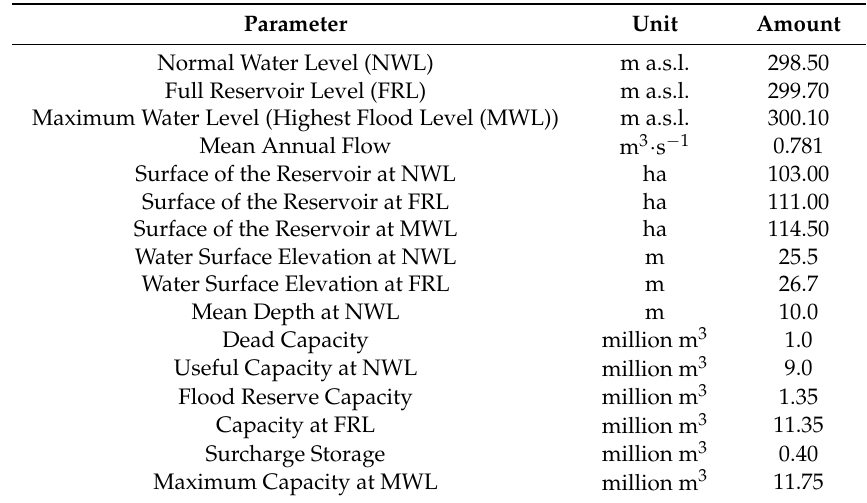
Figure 1. Location of the Dobromierz Reservoir. Table 1. Basic parameters of the Dobromierz Reservoir Table 1. Basic parameters of the Dobromierz Reservoir [35].